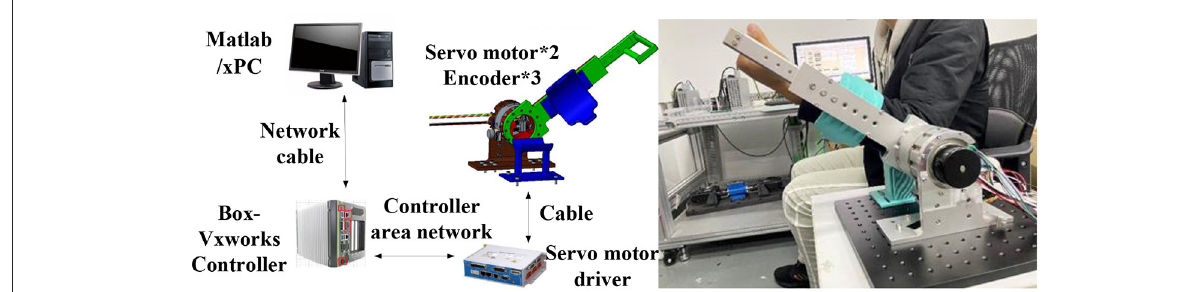
FIGURE11 Principle of variable stiffness joint experimental platform.